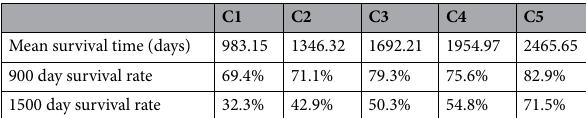
Table 7. Survival time of different subtypes of lung cancer.